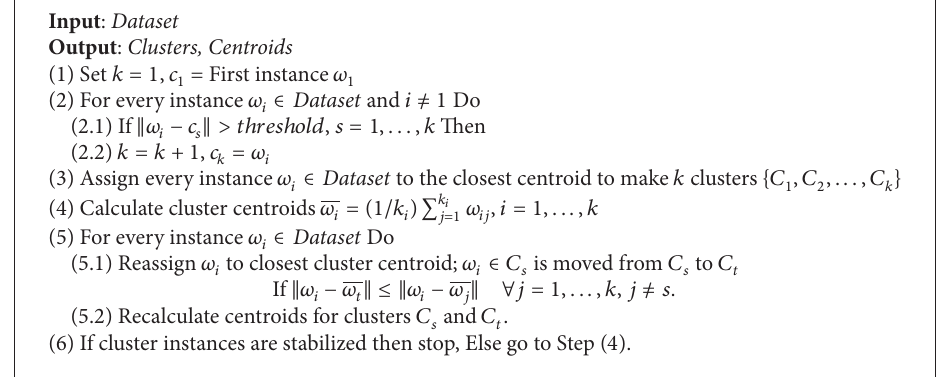
Pseudocode 2: Pseudocode of the modified 𝐾 -means